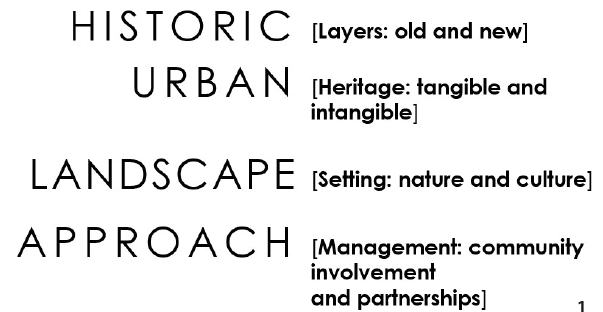
Figure 1 HUL approach and its attributes (Source: the